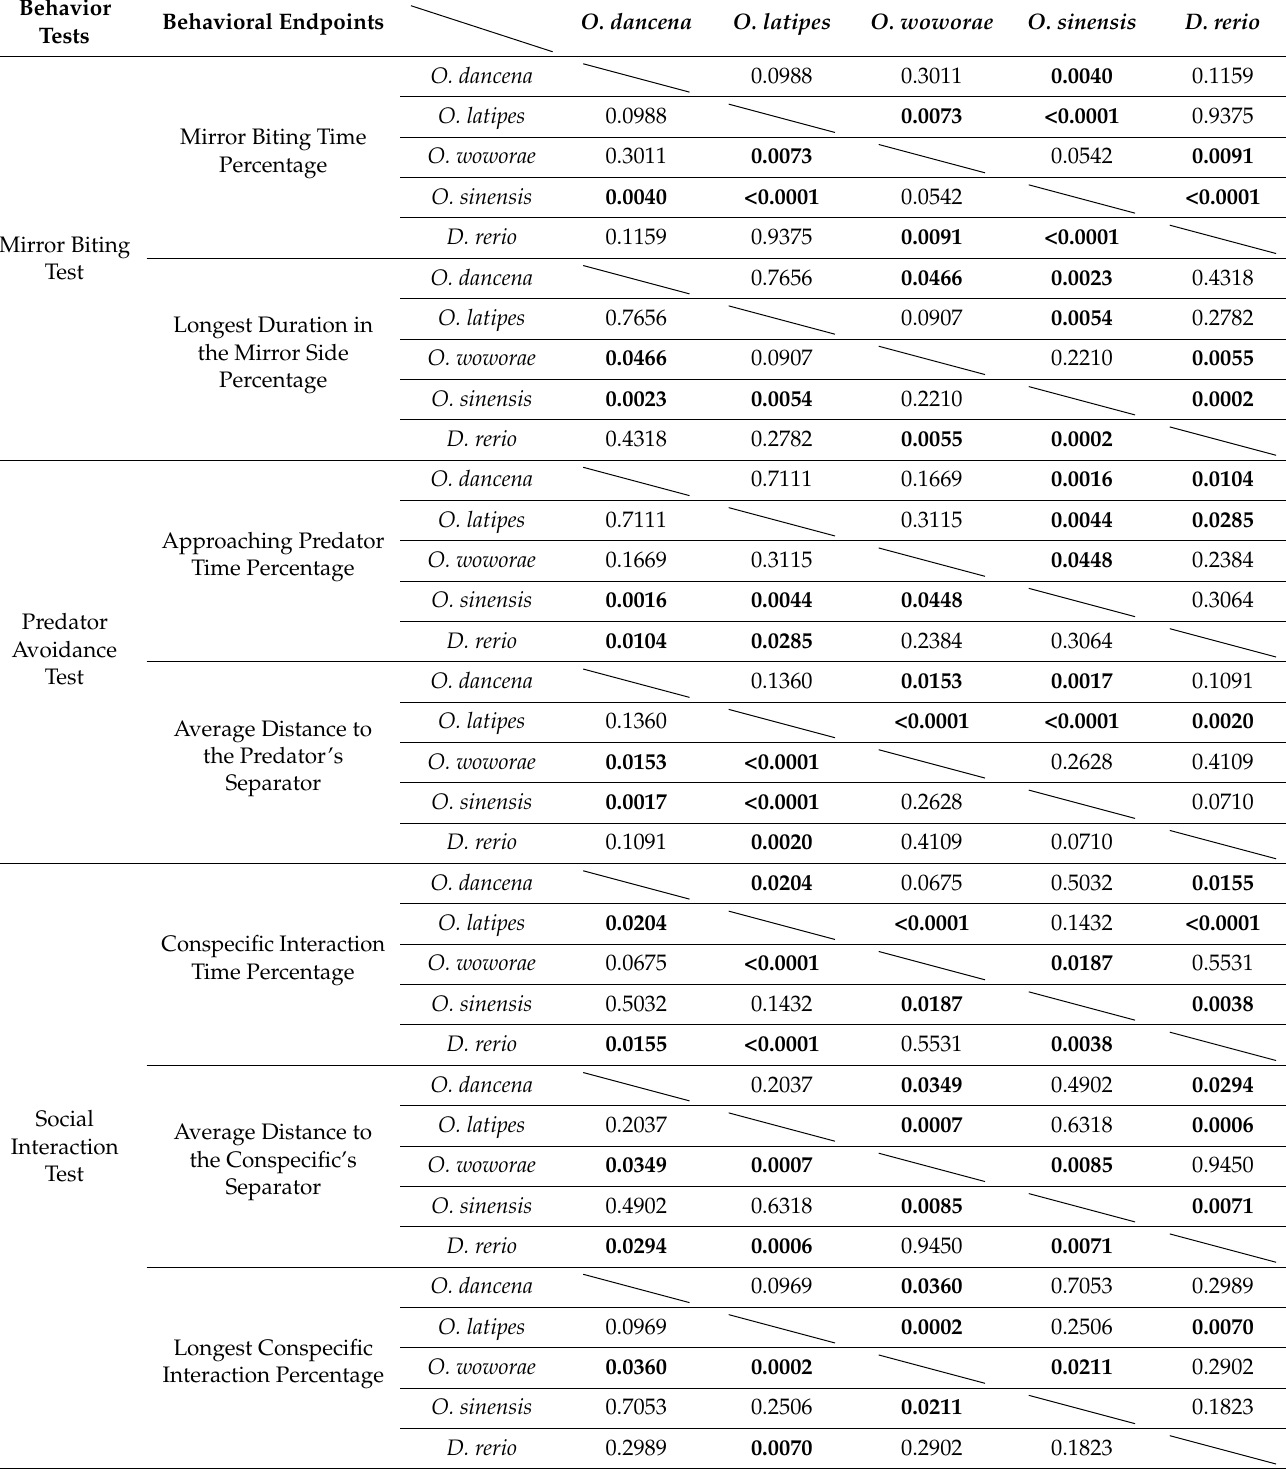
Table A2. The individual P-value of each fish behavioral endpoint comparison in behavior tests. The p -values were obtained from the Kruskal–Wallis test continued with uncorrected Dunn’s LSD test. p -values less than 0.05 are written in